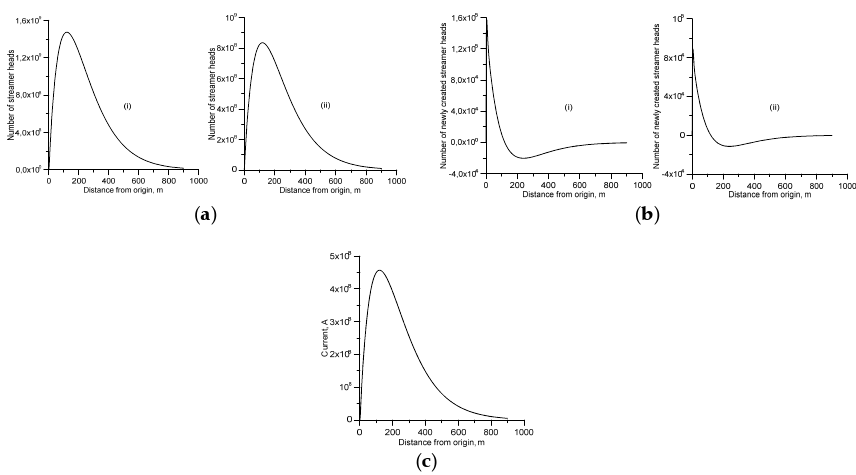
Figure 9 . ( a ) Number of forward moving streamer heads present at a given location. Curves i and ii correspond to non-conducting and partially conducting streamer channels; ( b ) number of newly created streamer heads as a function of distance from the origin; ( c ) peak current (sum of the currents associated with the forward moving streamer heads) associated with the forward moving front of the streamer burst corresponds to the curve i in (a). Curves i and ii correspond to non-conducting and partially conducting streamer channels.